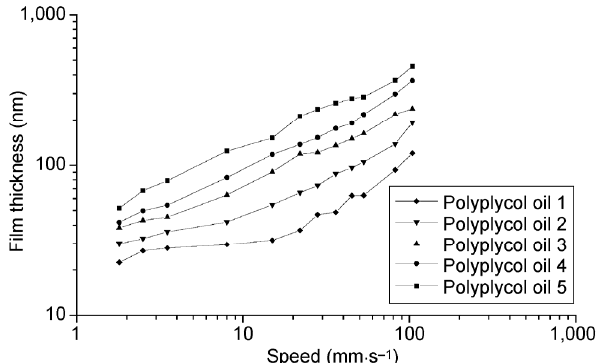
Fig. 9 Effect of viscosity on film formation performances of polyplycol oil (Pressure: 0.184 GPa, Temperature: 28 ° C), reported by Luo et al.